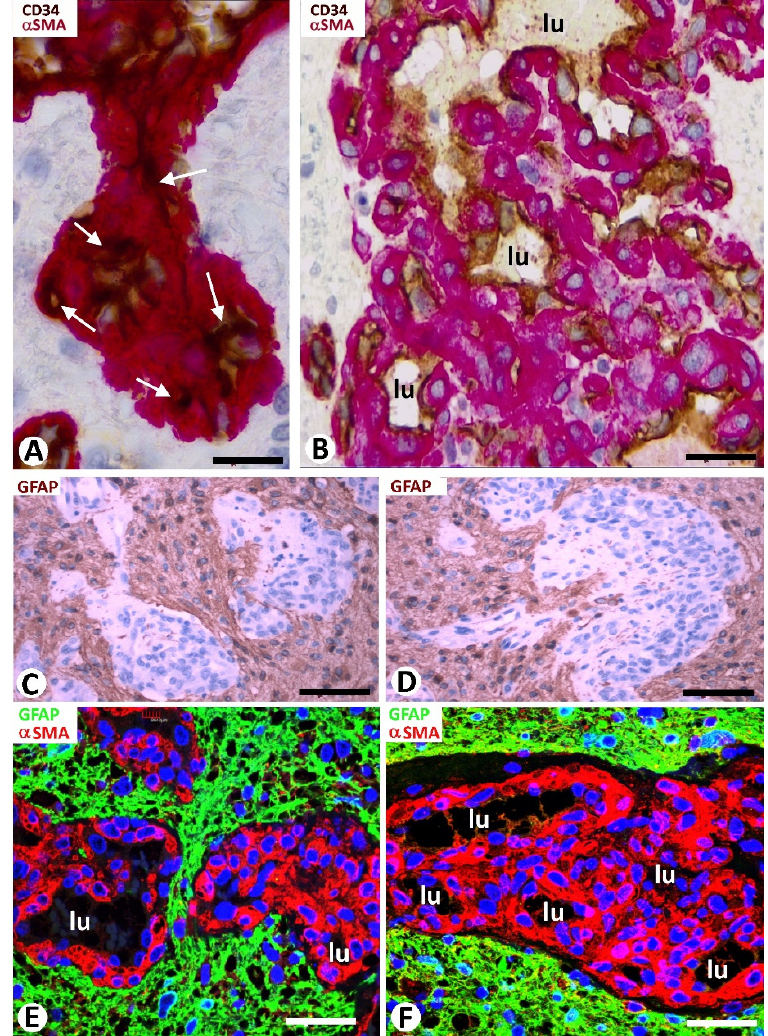
Figure 2. Cellular components of the bizarre vessels and their relationship with neoplastic cells in GBM. ( A , B ) α SMA + pericytes (red), increased in number and size, are observed around ECs (brown) of vessels with virtual lumen ( A , arrows) or with small lumen ( B , lu in a glomeruloid body). ( C – F ) The neoplastic glial cells (brown in C , D ; green in E , F ) are observed around glomeruloid bodies (hematoxylin-stained nuclei in ( C , D ); α SMA-stained pericytes in ( E , F ). Vessel lumen: lu). Note rows of neoplastic glial cells separating glomeruloid bodies in ( C , E ). ( A , B ) Double immunochemistry for CD34 (brown) and α SMA (red). Hematoxylin counterstain. ( C , D ) Immunochemistry for GFAP (glial fibrillary acidic protein) (brown). Hematoxylin counterstain. ( E , F ) Double immunofluorescence for GFAP (green) and α SMA (red). DAPI counterstain. Bar: ( A , B ) 20 µm, ( C , D ) 45 µm, and ( E , F ) 40 µm .